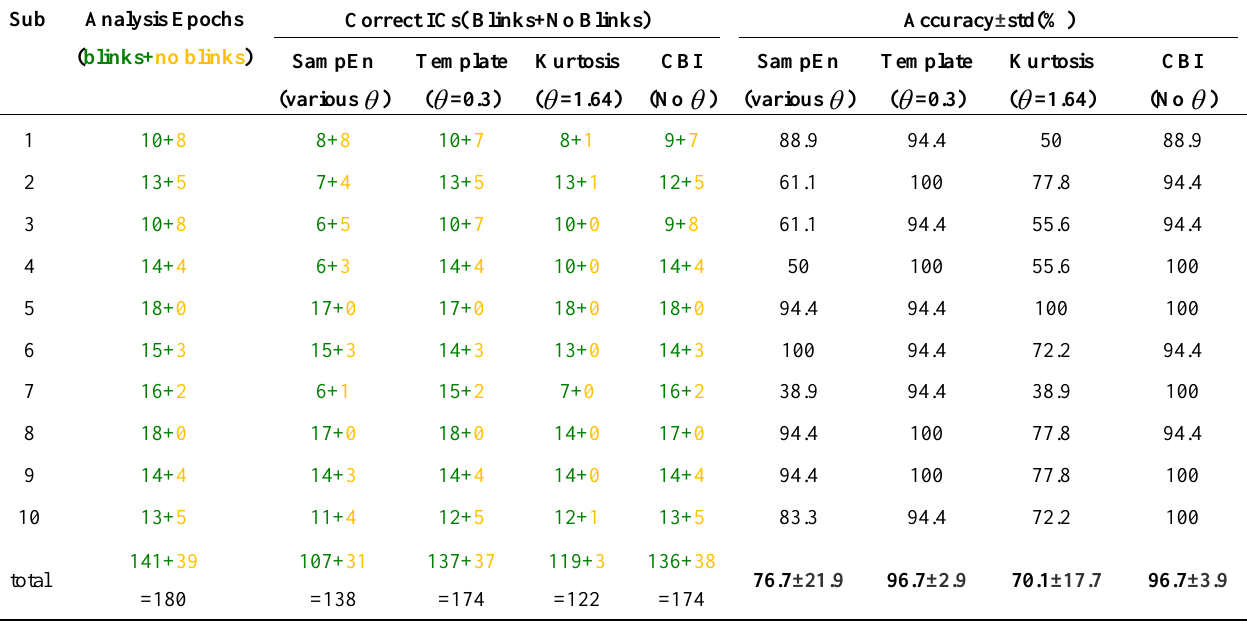
Table 2. The comparison results of four methods on the second dataset ( θ — threshold